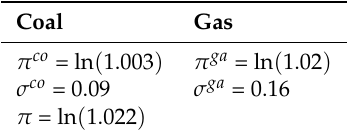
Table A3. Dynamical